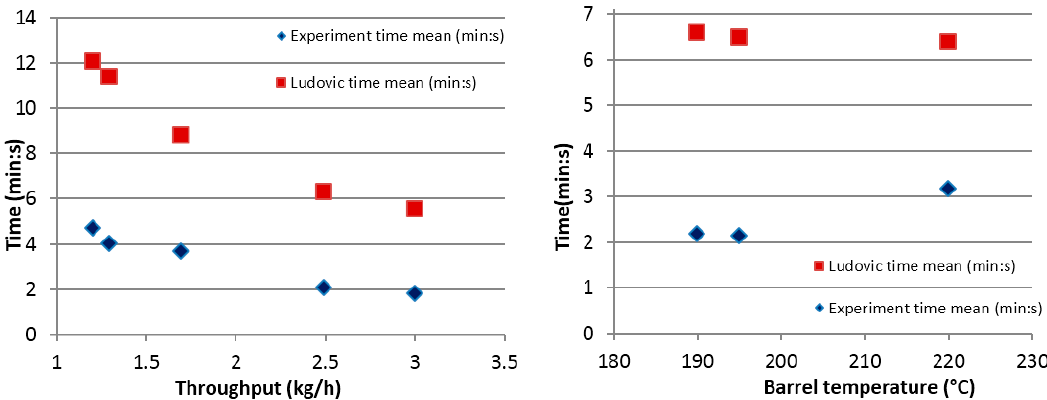
Figure 8. RTD Comparison for Ludovic simulated ( red dots) and experimental ( blue dots) results for throughput and barrel temperature.